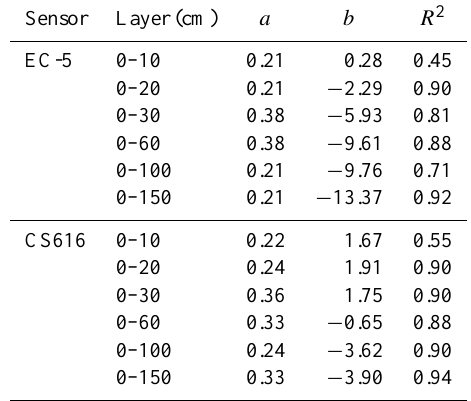
Table 3. Fitted parameters for cumulative volume change outside the structural shrinkage phase at field B in 2010, where 1V = a1W + b , and goodness of fit R 2 between fit and